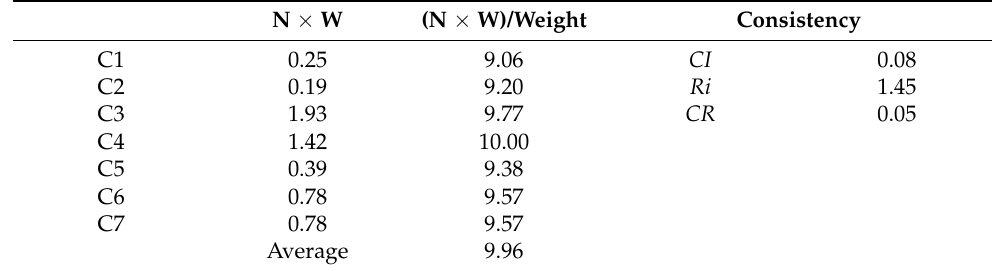
Table A3. AHP consistency calculation.